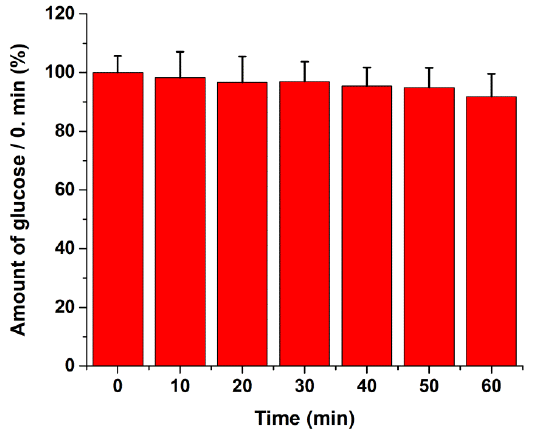
Figure 3. Stability study of glucose in the intracellular glucose assay using the glucose extraction (GEX) solution. HepG2 cells, mean values ± SD of eight technical replicates at each time point are shown.